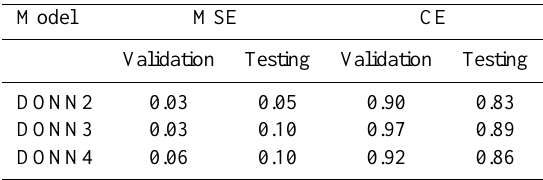
Fig. 11. Scatter diagrams of the predicted versus observed DO for validation (in green dot) and testing (in yellow dot); (a) DO-NN2, (b) DO-NN3 and (c) DO-NN4. Table 6. Coefficient of Efficiency (CE) and Mean Square Error (MSE) associated with MLP-NN models for each station at Johor River.